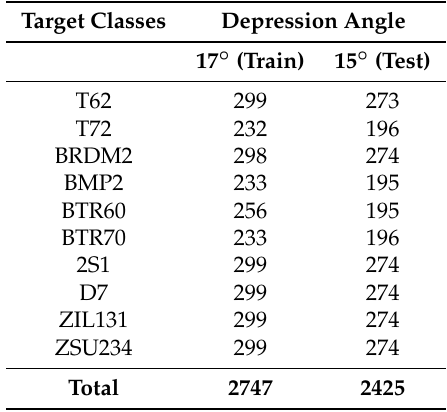
Table 3. Number of SAR images in MSTAR database under SOC.